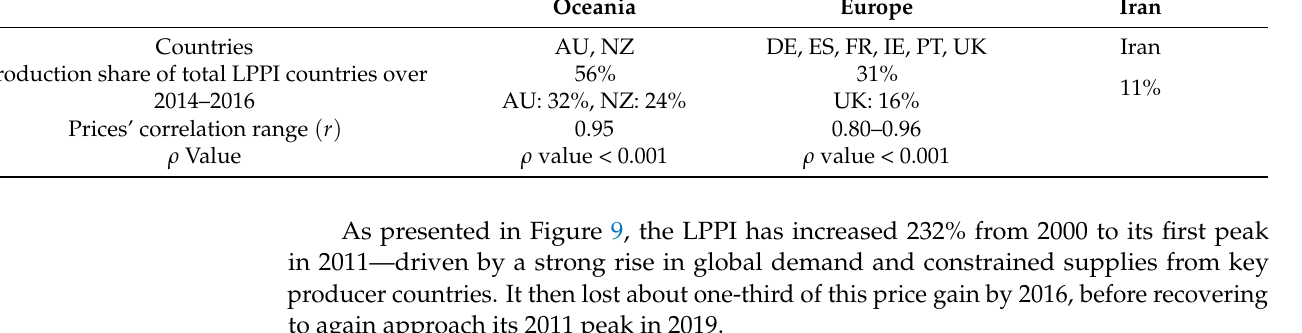
Table 2. Overview of the introduced regional LPPIs, source: own illustration. Oceania Europe Iran